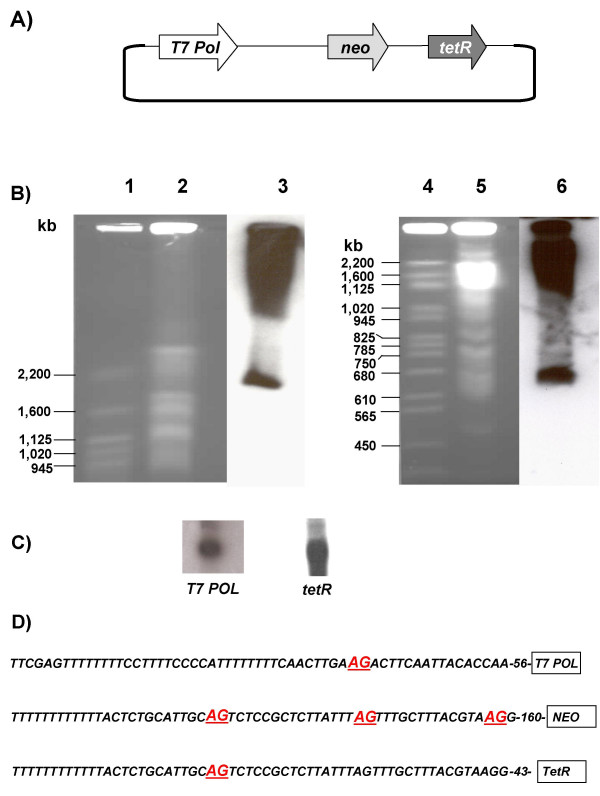
Production of cell lines stably expressing tetR and T7 RNA polymerase. (A) Simplified map of pLEW13 indicating the relative locations of the three transgenes [7]. (B) CHEFE analysis of chromosomal DNA isolated from CL-Brener [pLEW13] epimastigotes showing aberrant migration of the pLEW13 DNA. Lanes 1–3, a 0.8% PFC agarose CHEFE gel (auto-algorithm set for 300 kb-3 Mb separation). Lanes 1 (Saccharomyces cerevisiae size standards (Bio-Rad)) and 2 (CL-Brener [pLEW13]), the ethidium bromide stained gel. Lane 3, an autoradiograph obtained with the T7 RNA polymerase probe. Lanes 4–6, a 1.0% PFC agarose CHEFE gel (auto-algorithm set for 300 kb-1 Mb). Lanes 4 (S. cerevisiae size standards) and 5 (CL-Brener [pLEW13]), the ethidium bromide stained gel. Lane 6 is an autoradiograph obtained with the T7 RNA polymerase probe. Molecular sizes are given in kb. (C) Expression of the transgenes for T7 RNA polymerase and tetR in pLEW13 transformed epimastigotes. 10 μg total RNA was blotted and hybridised with either the T7 RNA polymerase (T7 POL) or tetR probes. (D) Splice acceptor sites used by T. cruzi to process the transcripts as mapped by RT-PCR. The AG dinucleotide sites of spliced leader addition identified following sequencing of the RT-PCR products are red and underlined. The numbers adjacent to the boxes indicate the distance in nucleotides between the sequence shown and the start codon of each gene. The T7 RNA polymerase is flanked by the T. brucei procyclin spliced leader acceptor site, whereas both neo and tetR are flanked by T. brucei actin spliced leader acceptor sites. In the case of the T7 RNA polymerase and tetR transcripts, only one addition site was identified; in the case of the neo transcript, three were found.